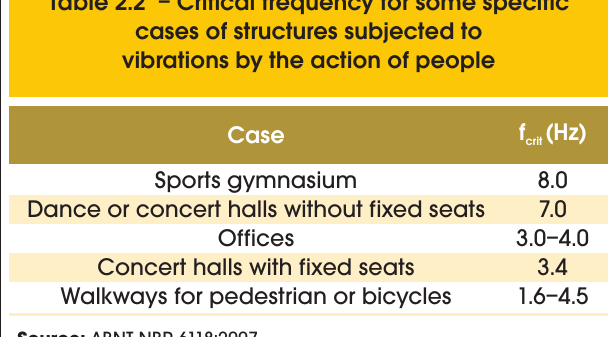
Table 2.2 – Critical frequency for some